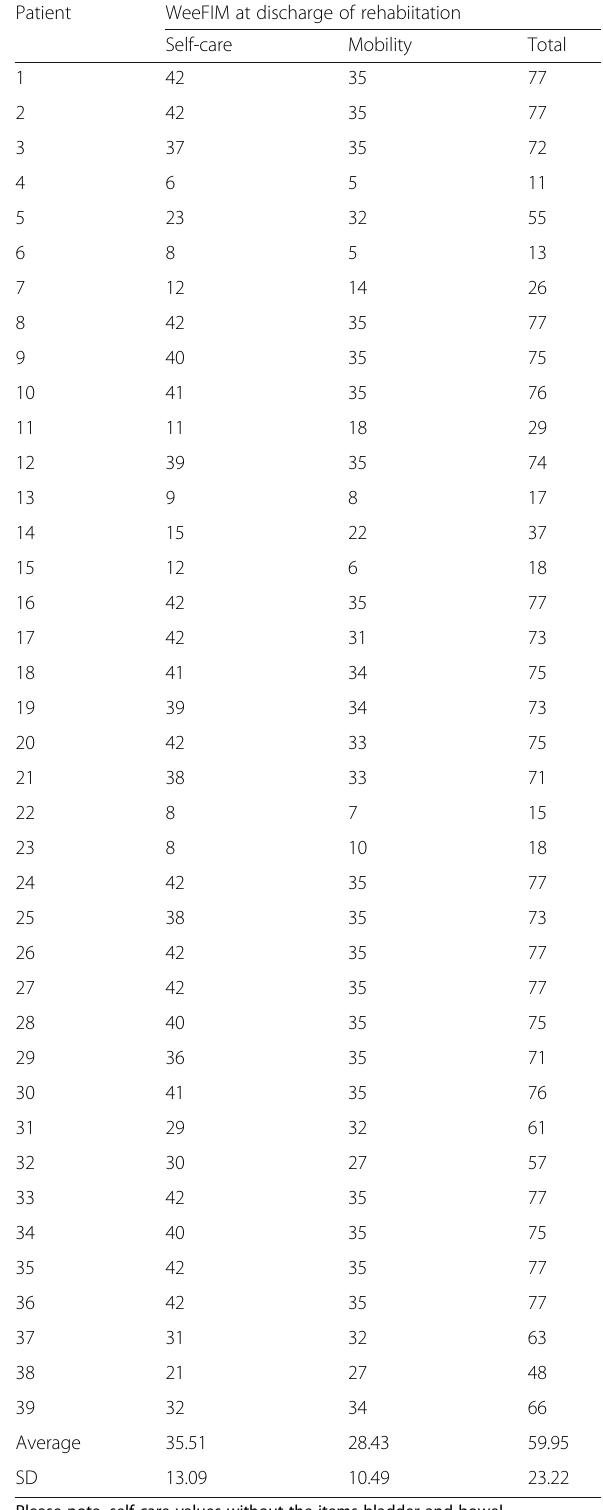
Table 2 Motor functional independence measure for children scores for each